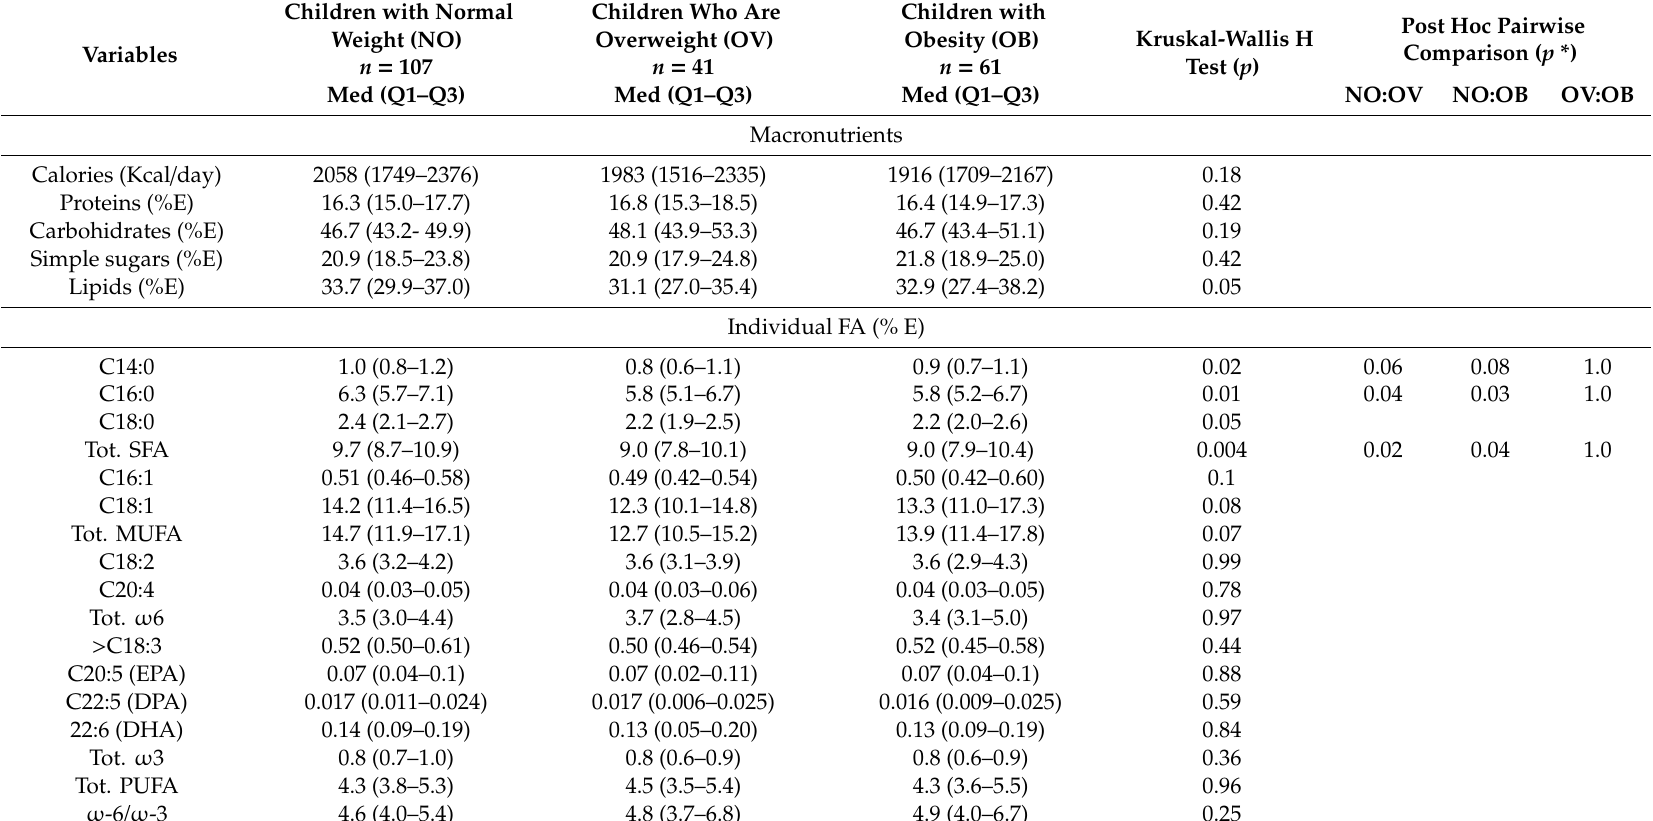
Table 2. Dietary daily intake expressed as % of energy